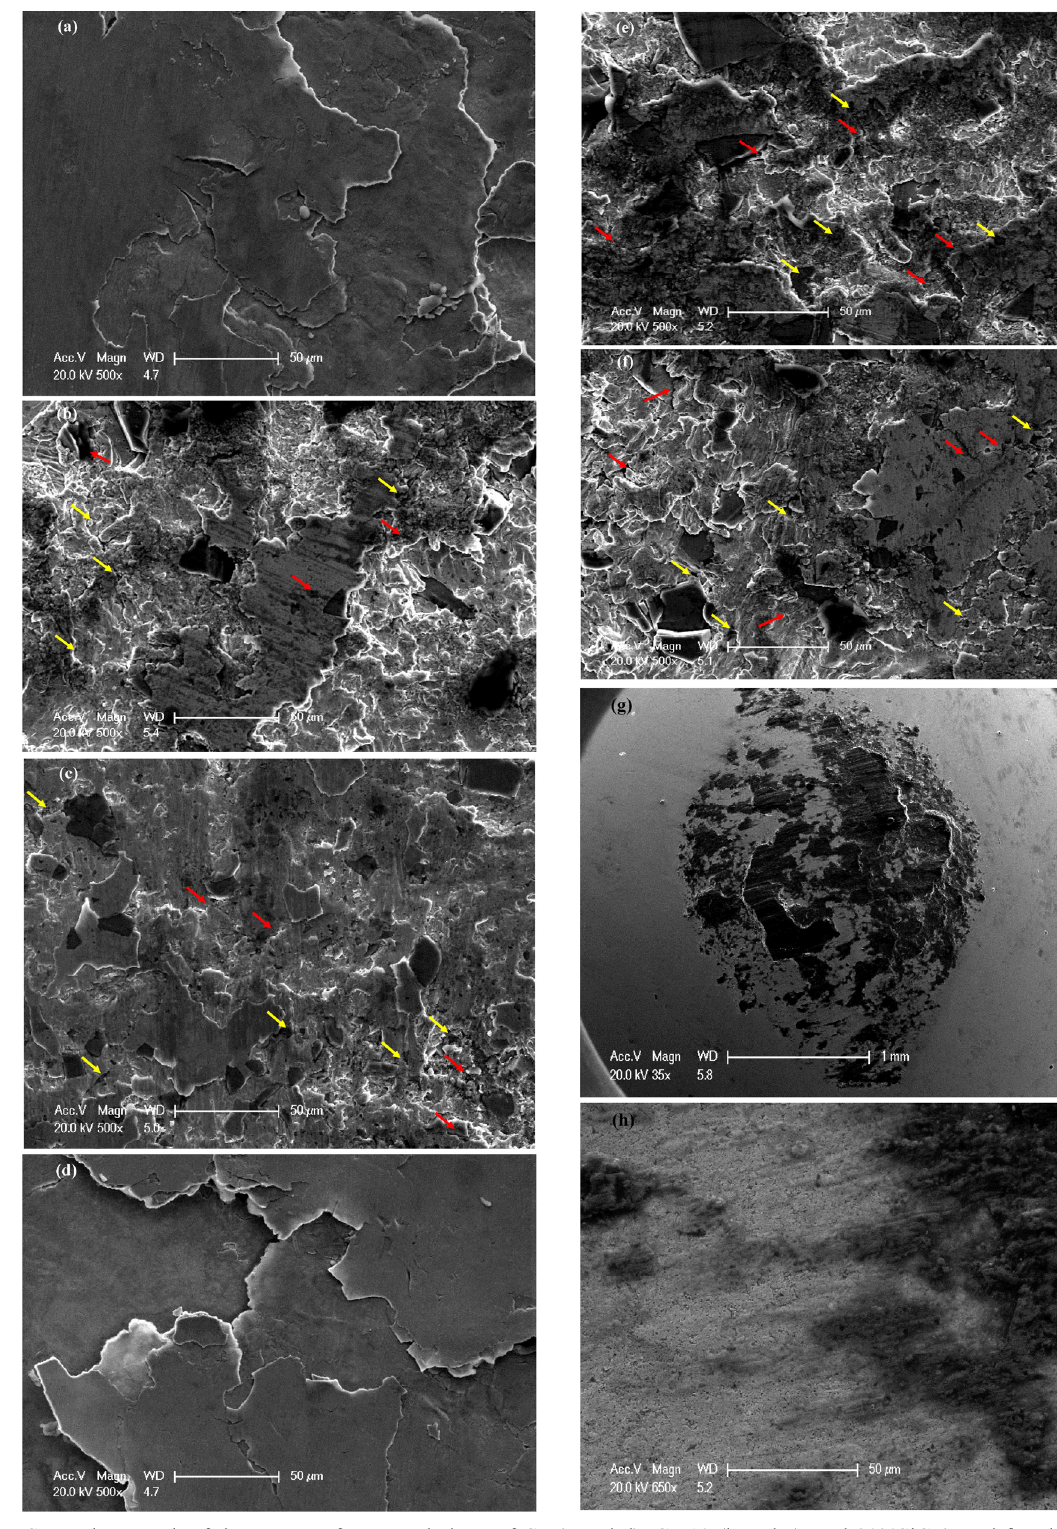
Fig. 10 SEM photograph of the worn surface morphology of Cu (a and d), Cu-10 (b and e), and 20%SiC (c and f) cold compacted samples corresponding to a sliding distance of 2,500 m and applied loads of 5 N (a–c) and 30 N (d–f), and (g–h) the corresponding WC wear surface morphology after the sliding against Cu-20%SiC cold compacted sample under sliding distance of 2,500 m and an applied load of 30 N under different